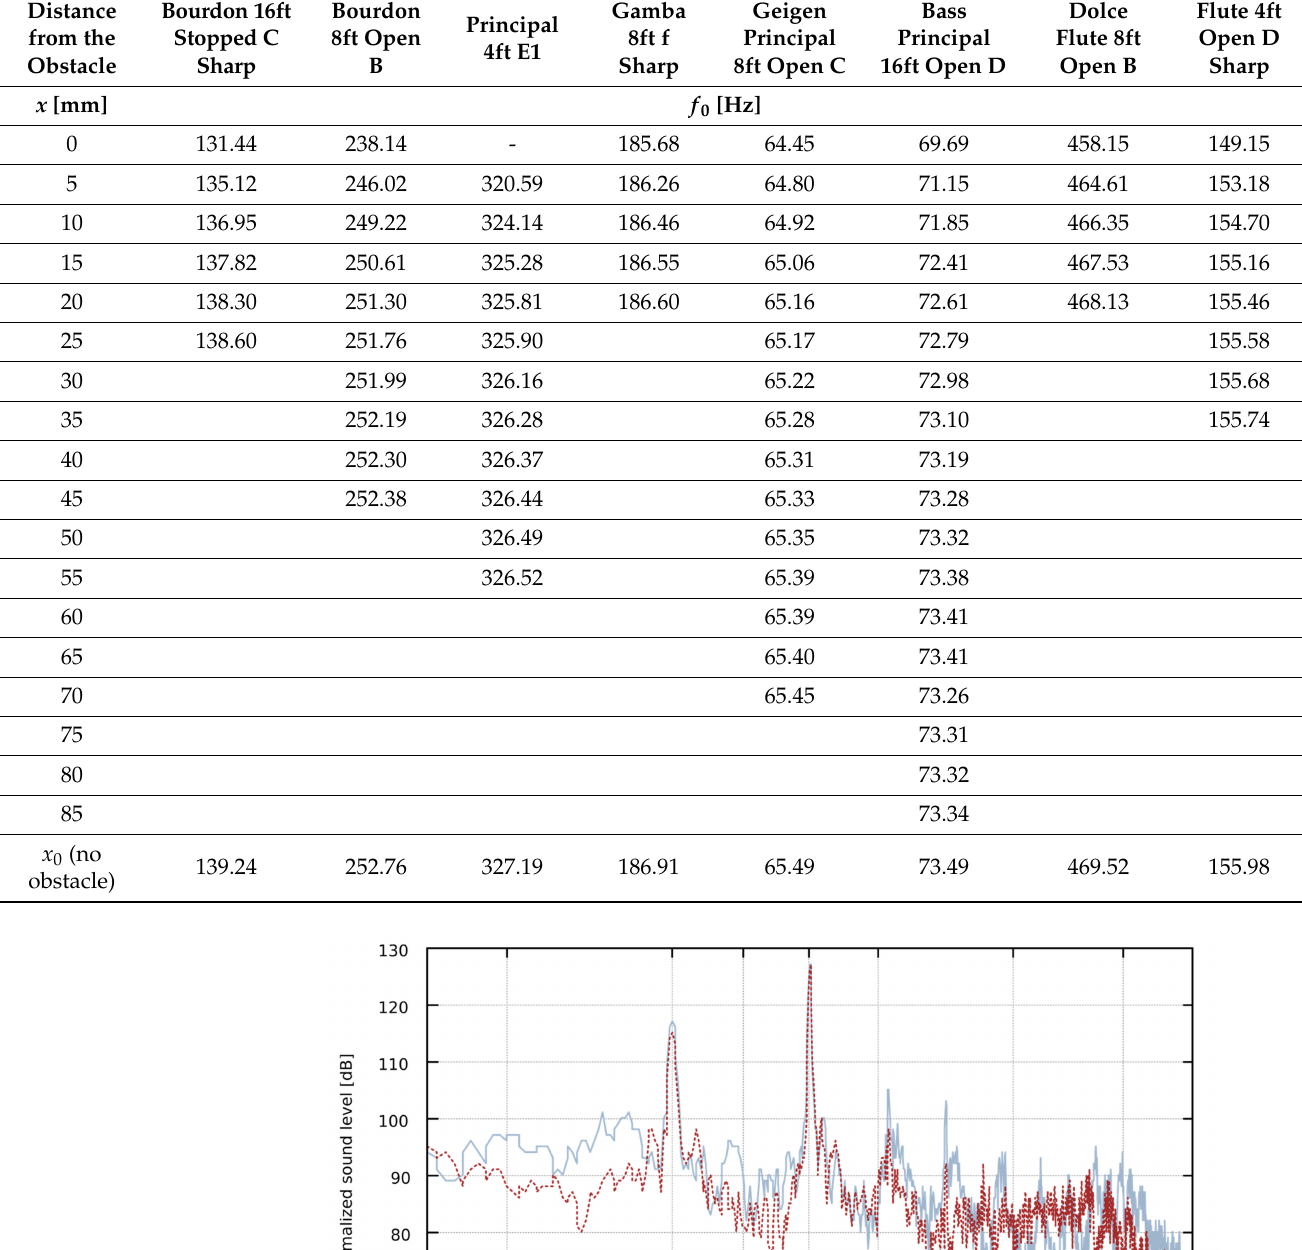
Table 2. The dependence of the pipe sound frequency on the distance of the obstacle to the mouth of the pipe (the symbol “-” denotes that the pipe generated no sound in this case).